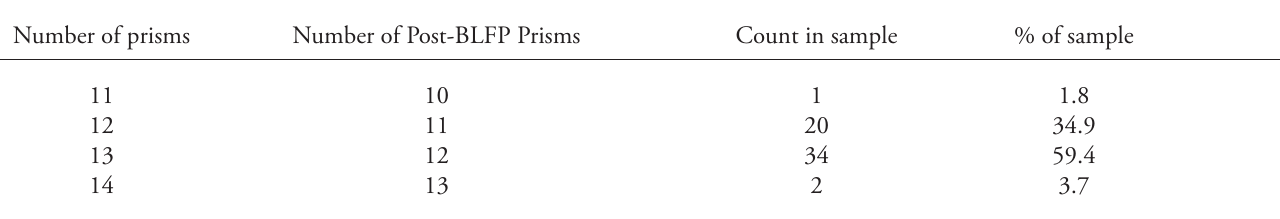
Table 6. M3 prism counts in Hydrochoerus hydrochaeris , data from Mones (1991); N =